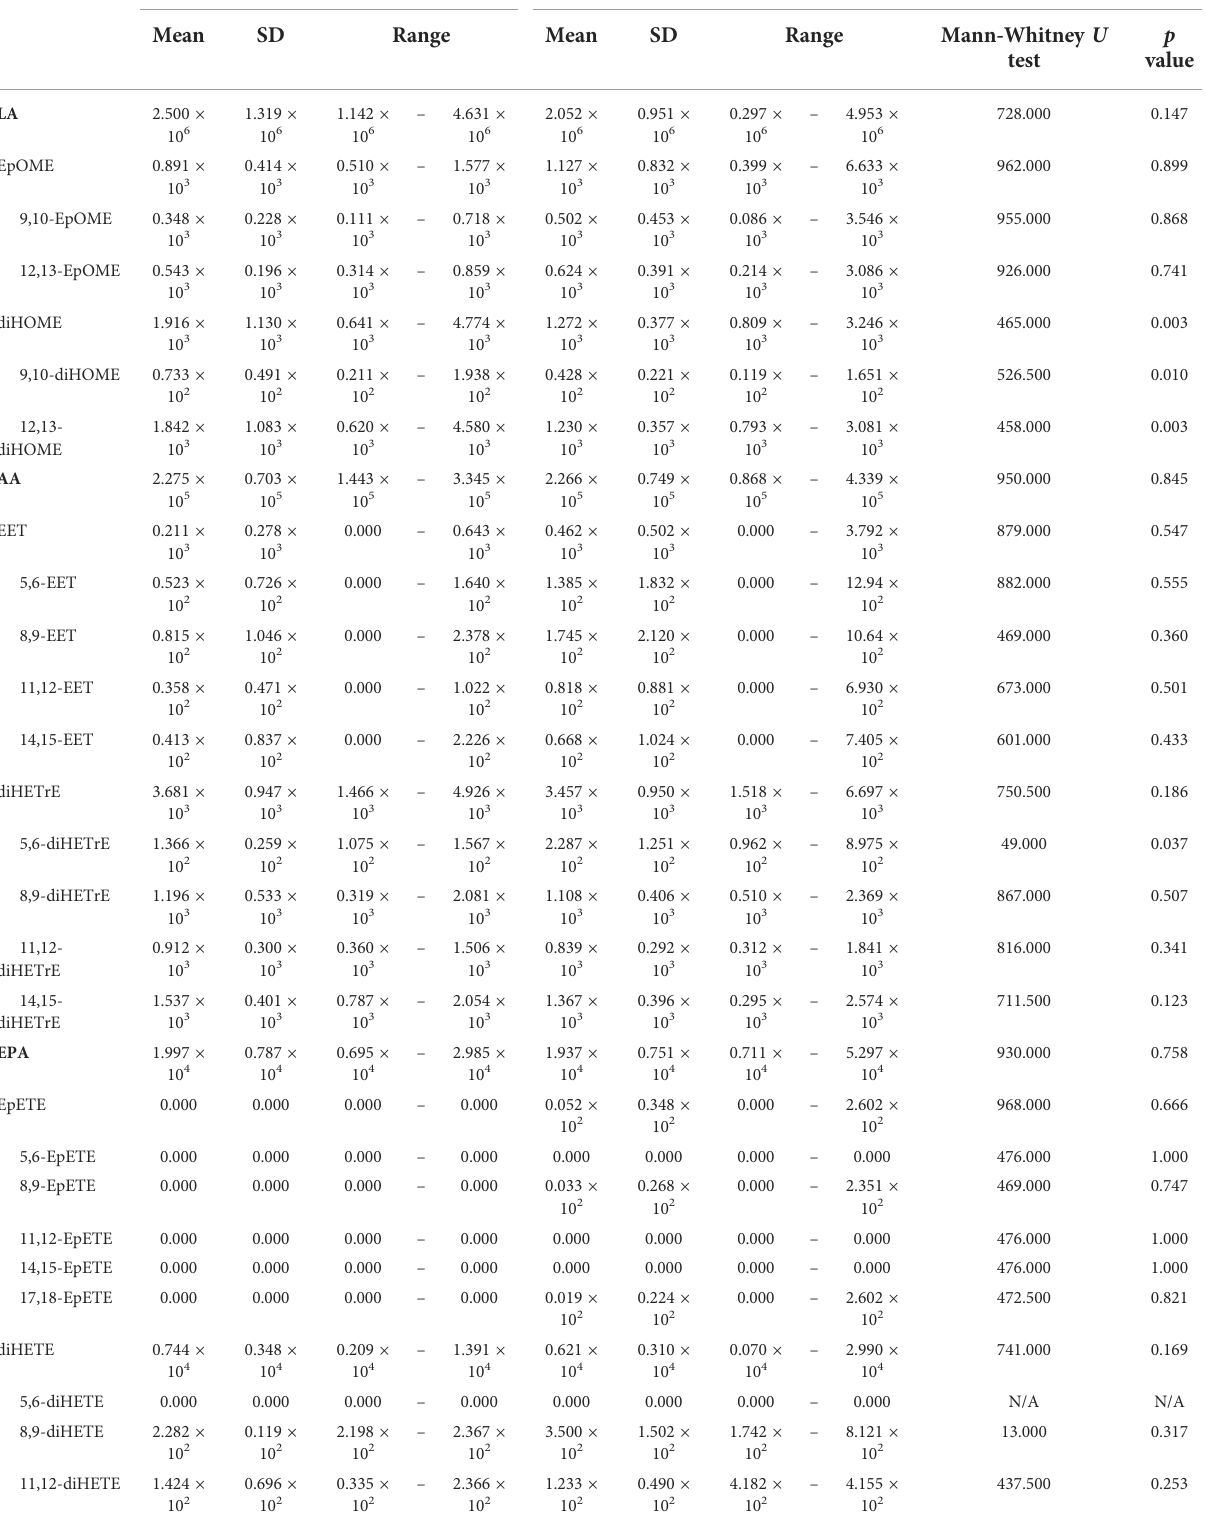
TABLE 6 Cord blood PUFA metabolite in SGA and AGA